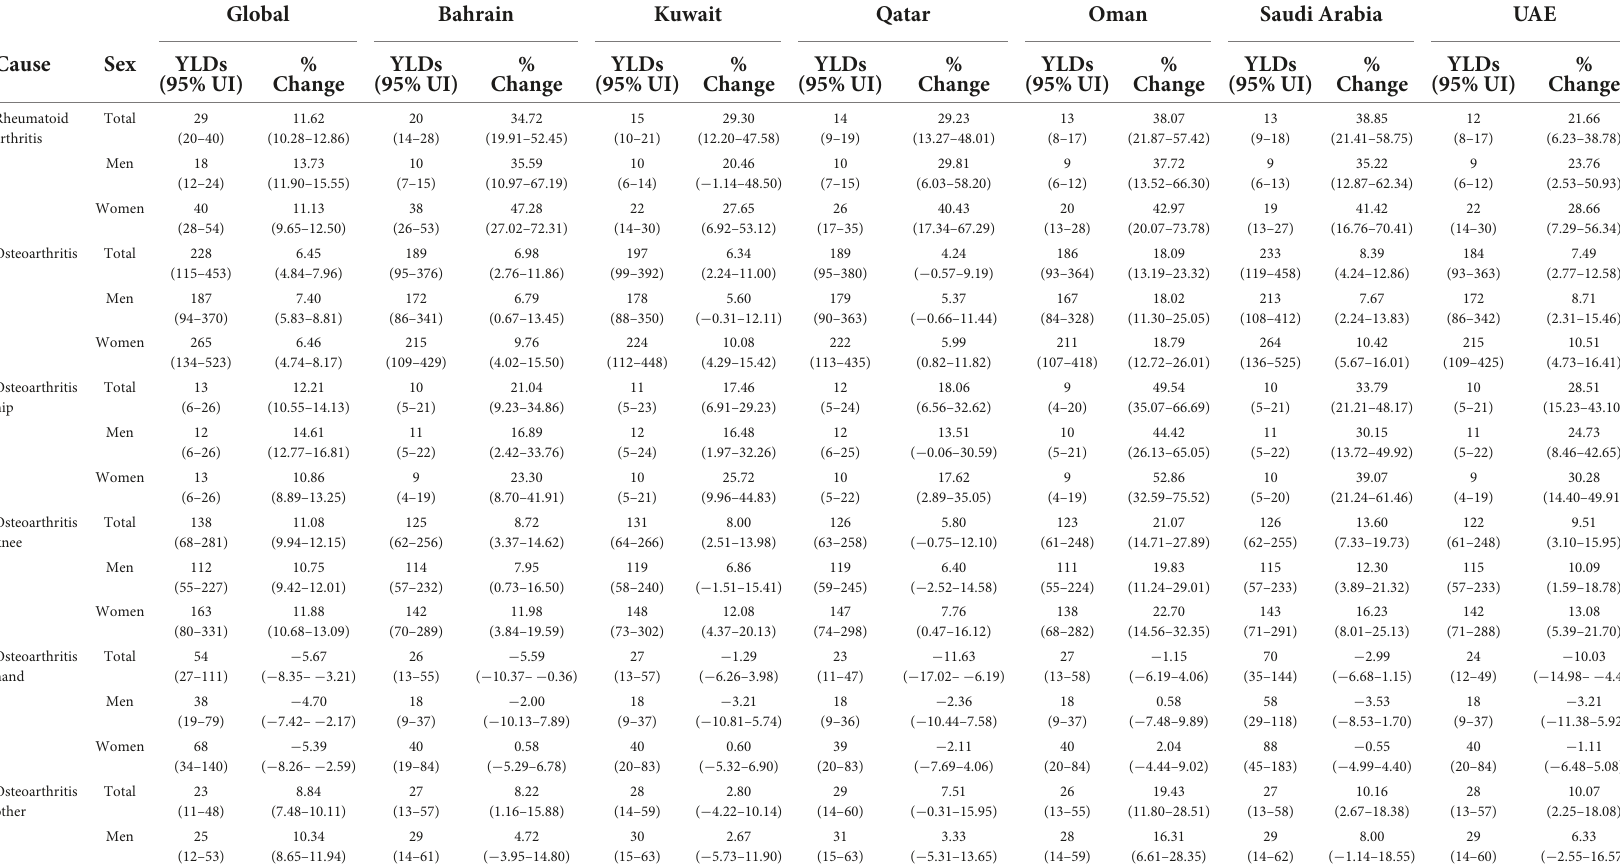
TABLE 4 Age-standardized YLDs (rates per 100,000 population) for different MSK disorders in the GCC countries in 2019 and the percentage change between 1990 and